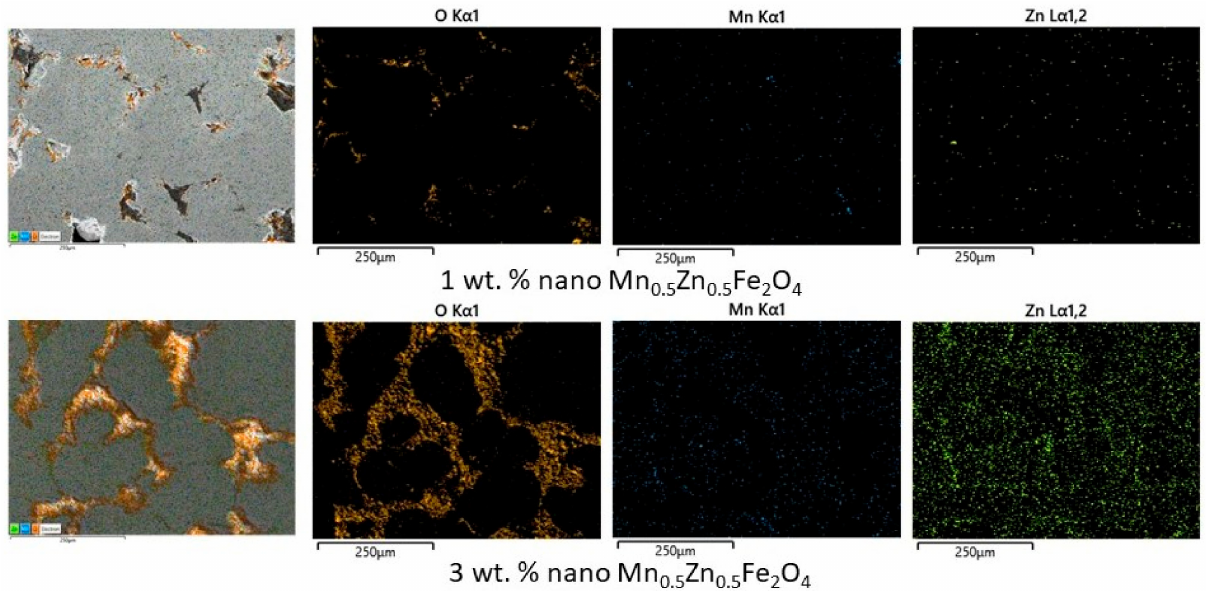
Figure 6. The influence of amount of nano MnZn ferrite on the microstructure of the Ni 3 Fe/Mn 0.5 Zn 0.5 Fe 2 O 4 SPS-ed composite compacts. Sintering parameters: sintering temperature— 700 ◦ C, sintering time—0 min. On the left side is the SEM image over which the O, Mn, and Zn distribution maps are